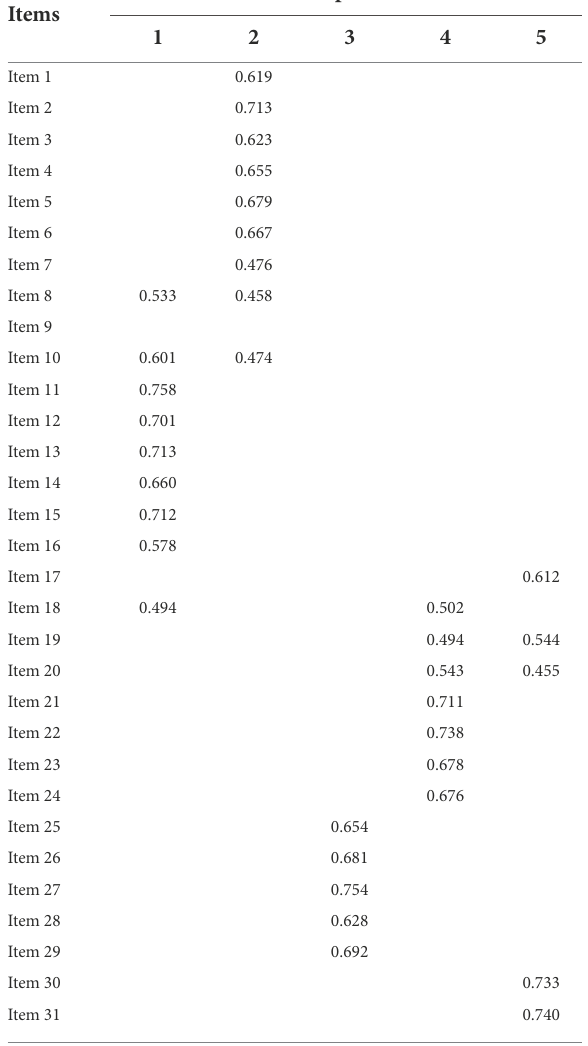
TABLE 4 Component matrix after